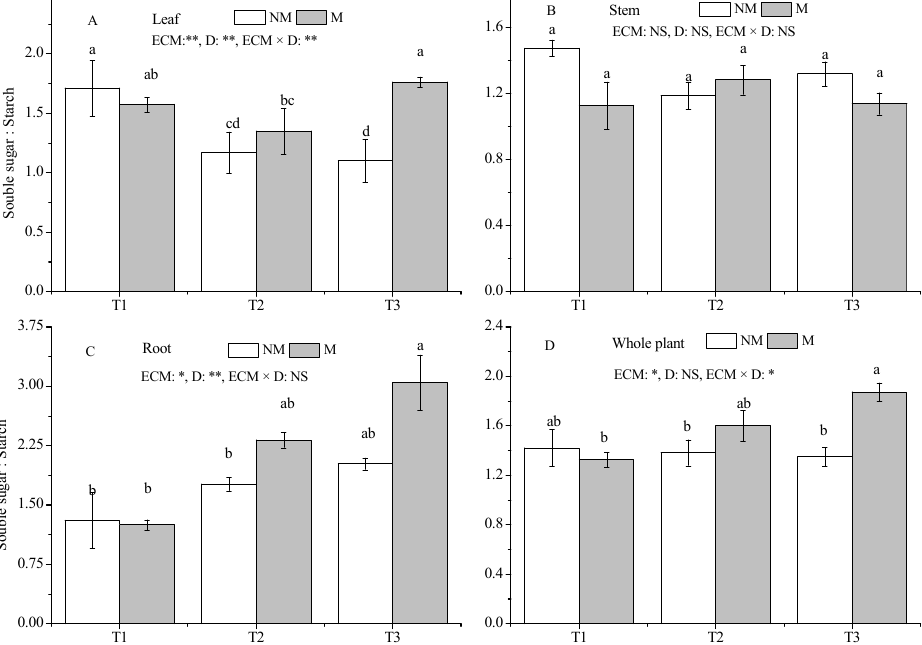
Figure 7. E ff ect of ECMF and drought on the SS/St ratio of various tissues and whole plants of P. massoniana. Values (means ± SEs) followed by di ff erent le tt ers among treatments indicate signi fi cant di ff erences at the 5% level, and the same le tt er indicates no signi fi cant di ff erence. NS, not signi fi cant, * p < 0.05; ** p < 0.01. T1, well-watered, T2, moderate drought, and T3, severe drought. NM, no Sl inoculation, M, Sl inoculation. D, drought treatment. The le tt ers denote ( A ) ratio of soluble sugar to starch of leaf ; ( B ) ratio of soluble sugar to starch of stem; ( C ) ratio of soluble sugar to starch of root; ( D ) ratio of soluble sugar to starch of whole plant.